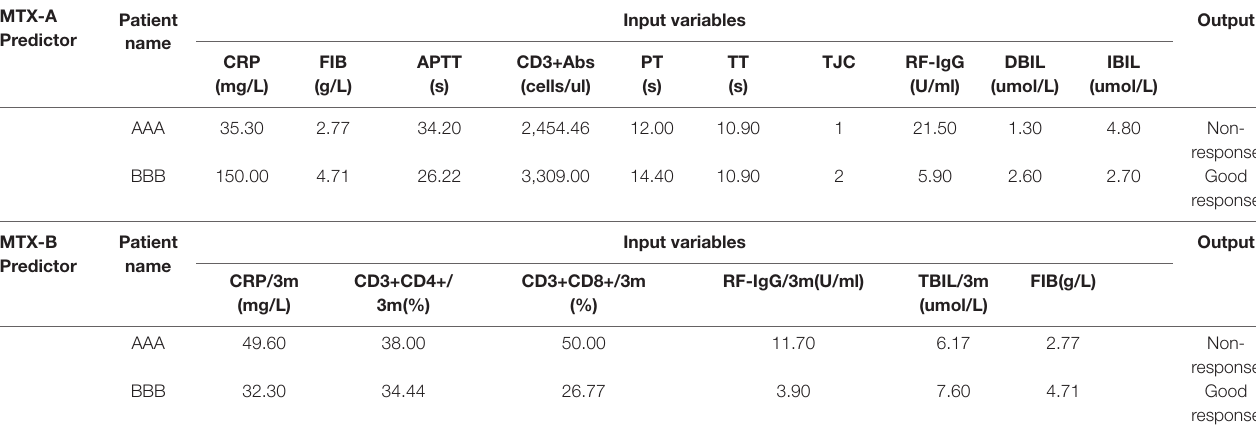
TABLE 4 | The application of XGBoost predictors for clinical patients to predict their response. MTX-A